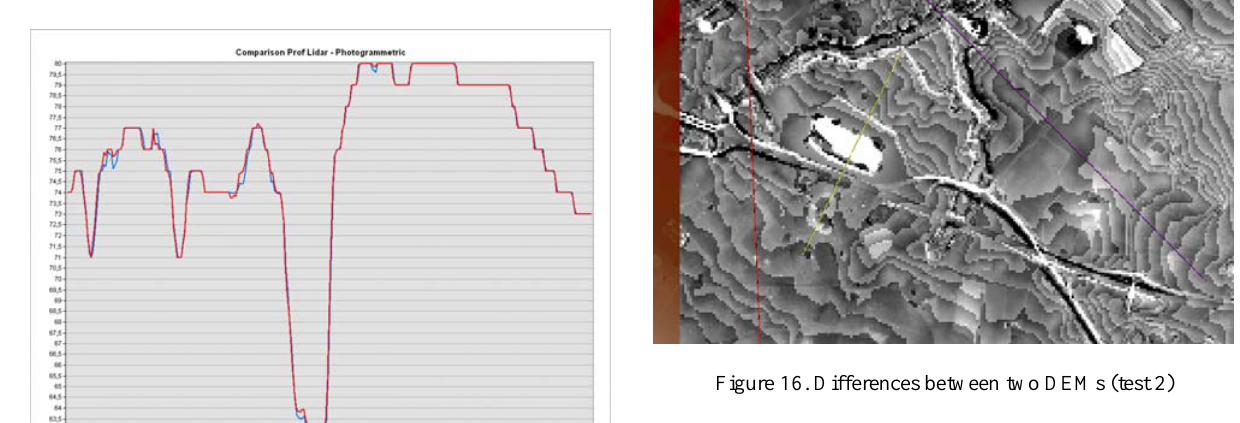
Figure 12. Comparison between profiles (test 2)